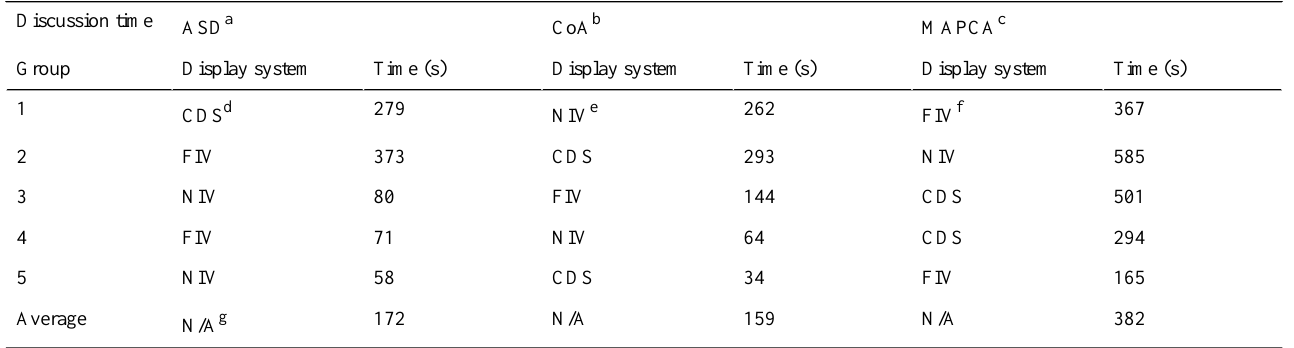
Table 5. Discussion times of the congenital heart disease variations for all groups and on